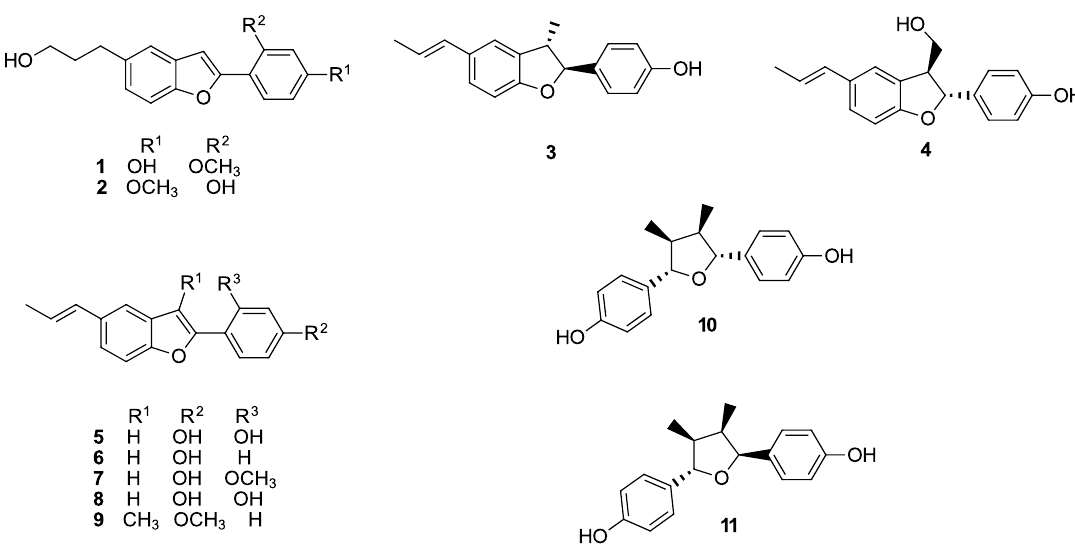
Figure 1. Lignan derivatives found in DCM extract of Rhatani root.